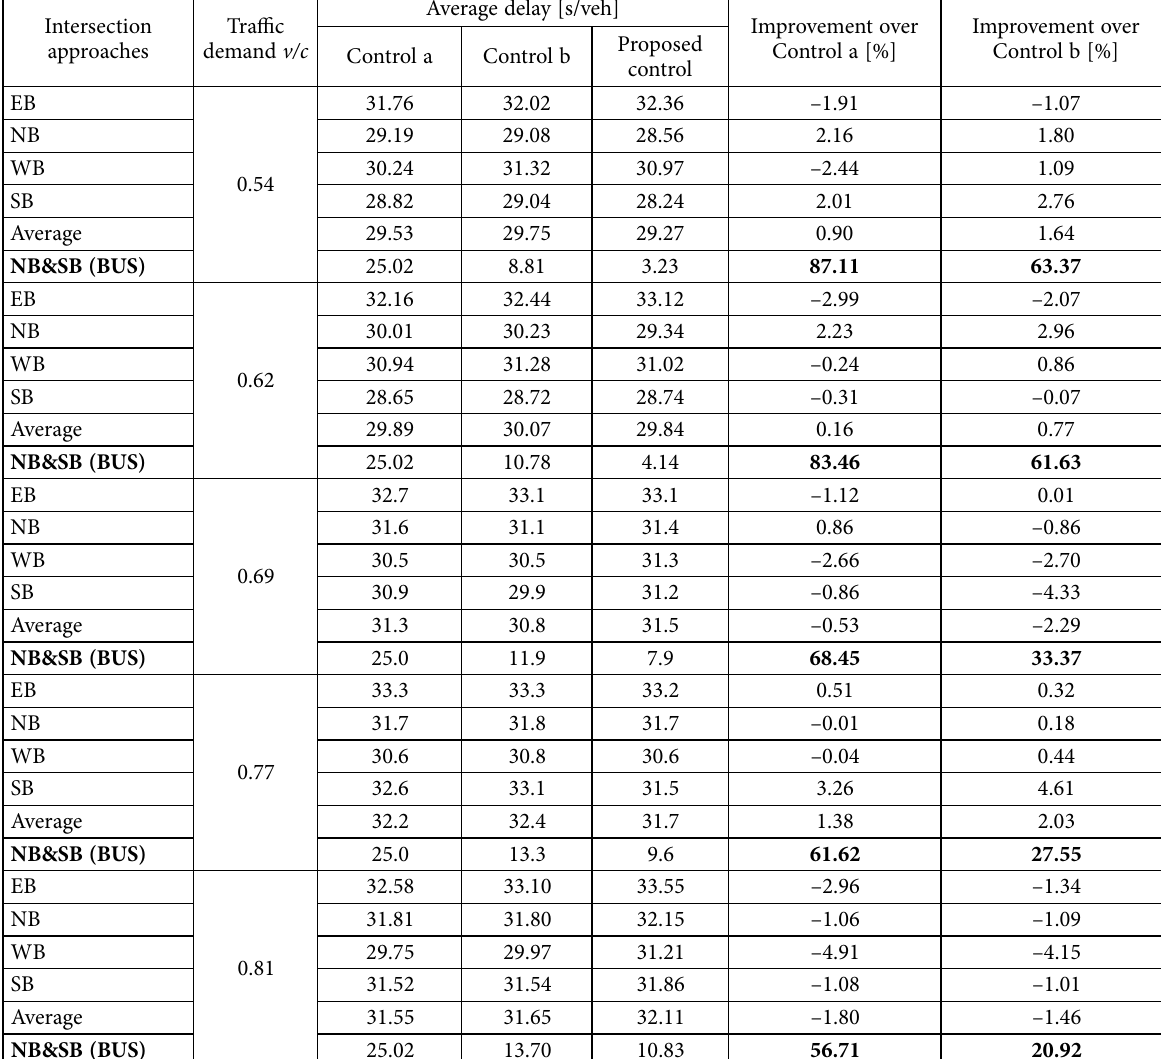
Table 4. Comparison results of model